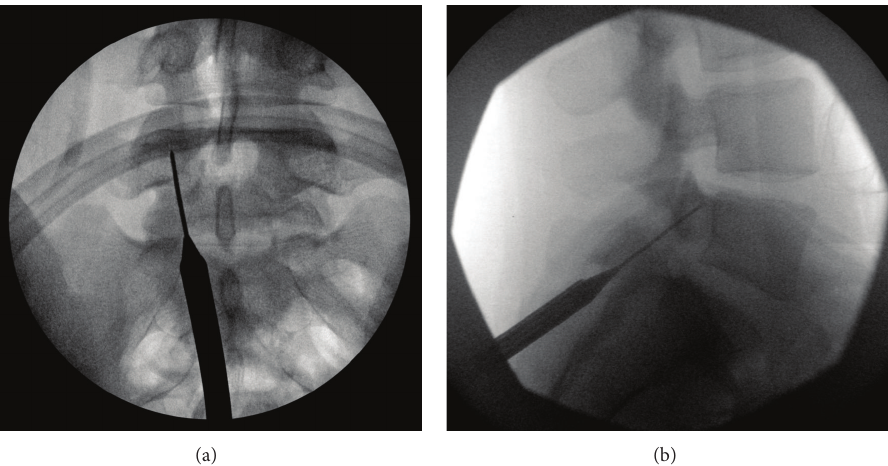
Figure 4: ((a) and (b)) The UCSS cannula is advanced towards the undersurface of the lamina and then the guide wire drilled across the pars defect.